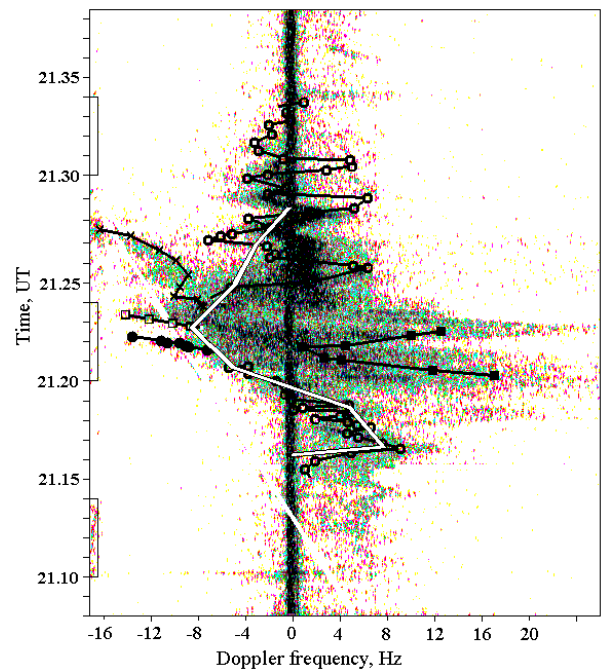
Fig. 9. Comparison between simulation results of Doppler fre- quency shifts f d and experimental dynamic Doppler spectra at 9410kHz on the London – Tromsø – St.Petersburg path during the HF pumping experiment on 16 February 1996. The white continu- ous line shows the calculated values of f d from Fig. 7c; the solid black lines present the calculated values of f d shown in Fig.